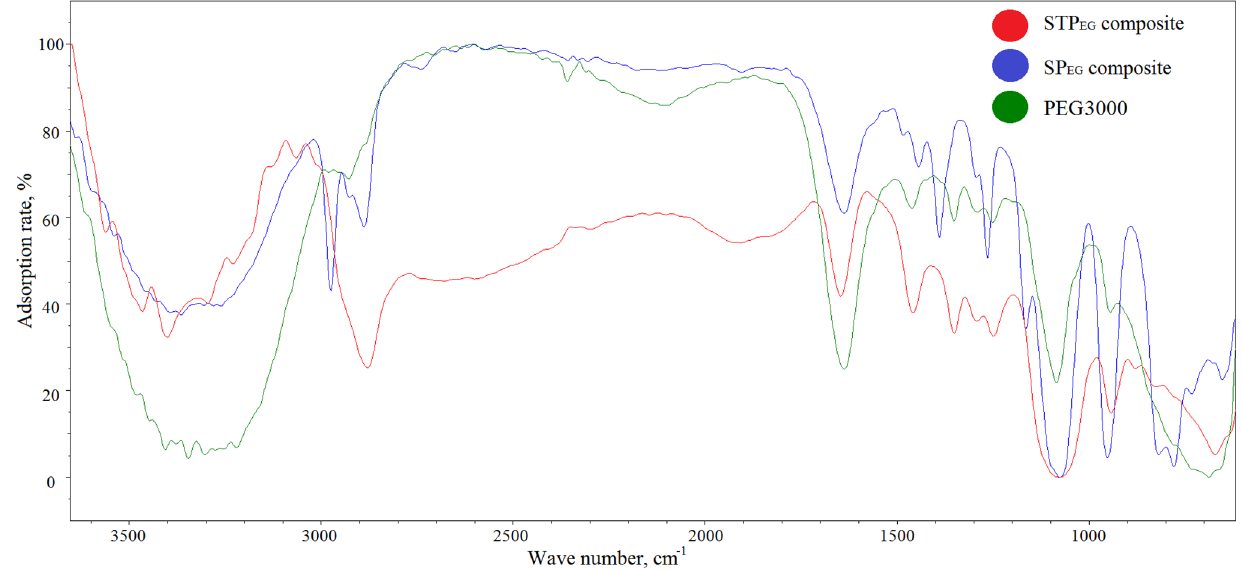
Figure 4. IR spectra of organosilica composites: red line, STP EG -composite; blue line, SP EG -composite; and green line, PEG3000.